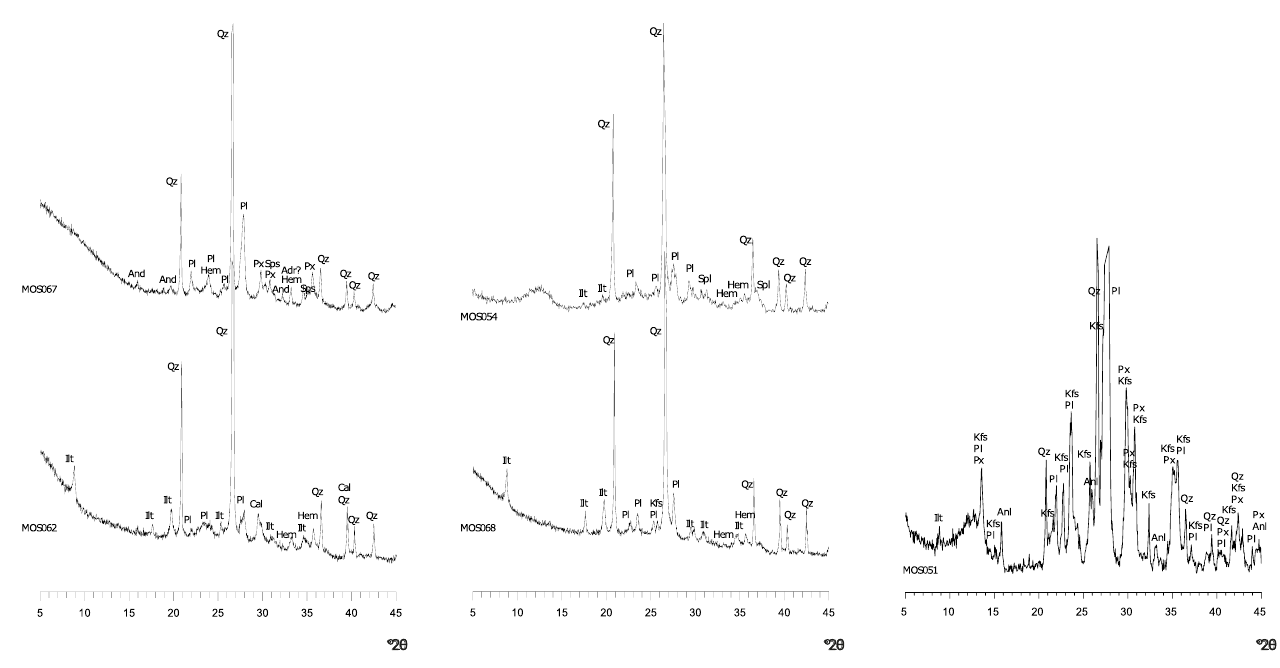
Figure 9. Examples of diffractograms of different PXRD fabrics. Bottom left: MOS062, fabric CGTOS- I. Top left: MOS067, fabric CGVEL-MAG-III. Bottom middle: MOS068, fabric CG17-I; top middle: MOS054, fabric CG19-I; right: loner CGMOS051. And: andalusite; Anl: analcime; Adr: andradite; Cal: calcite; Hem: hematite; Ilt: illite-moscovite; Kfs: K-feldspar; Pl: plagioclase; Px: pyroxene; Qz: quartz; Spl: spinel; Sps: spessartine. Abbreviations after [59] (except for Px).